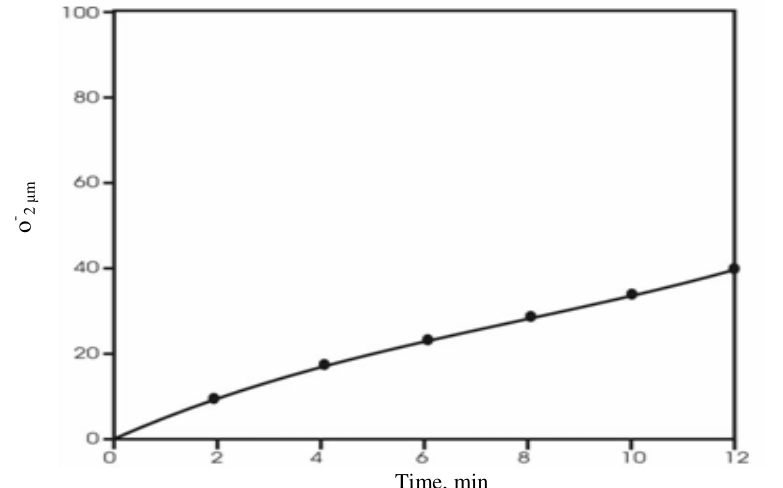
Figure 1. Dose–response relationship between 1 O benzanthrone 25 min.